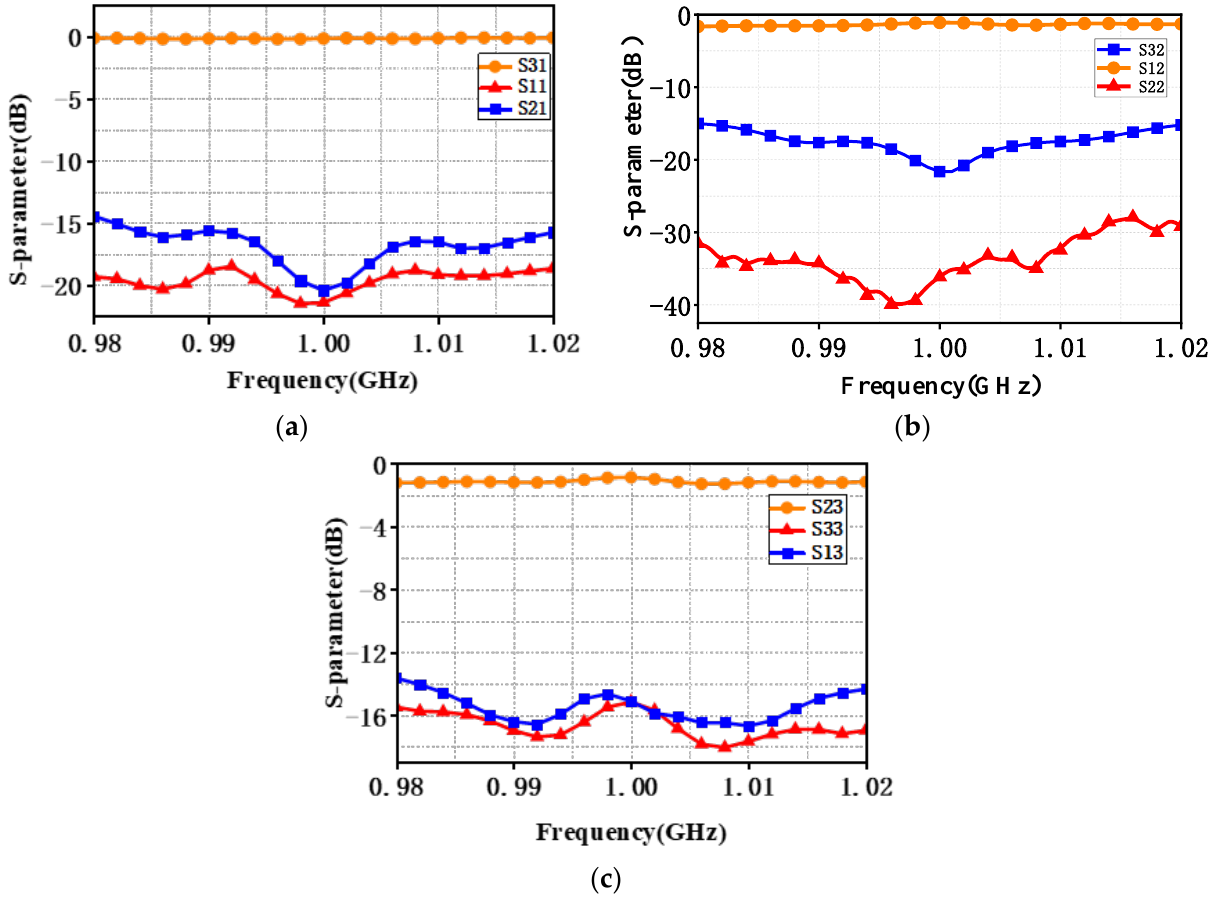
Figure 11. S-parameters of the designed circulator. ( a ) S11, S21, and S31. ( b ) S12, S22, and S32. ( c ) S13, S23, and